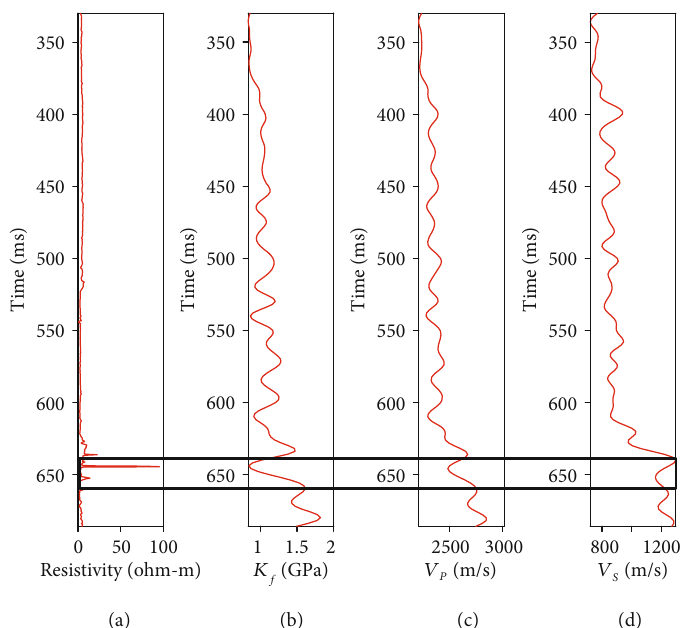
Figure 15: (a) The resistivity from the well log, and the inversion results of (b) K rectangle represents the location of the target stratum.